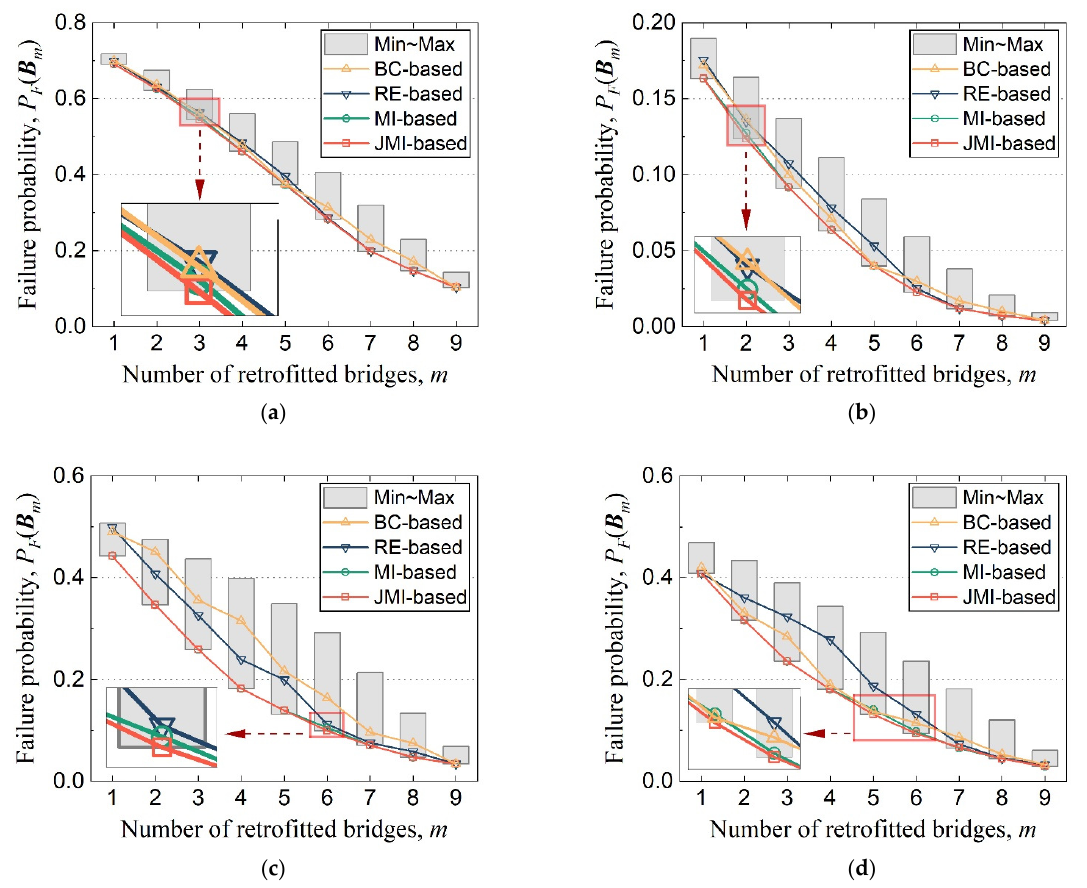
Figure 5. Network failure probability under different approaches and conditions. ( a ) Case 1; ( b ) Case 2; ( c ) Case 3; ( d ) Case 4. Table 4. Sum of failure probability gaps between each approach and optimal solution.